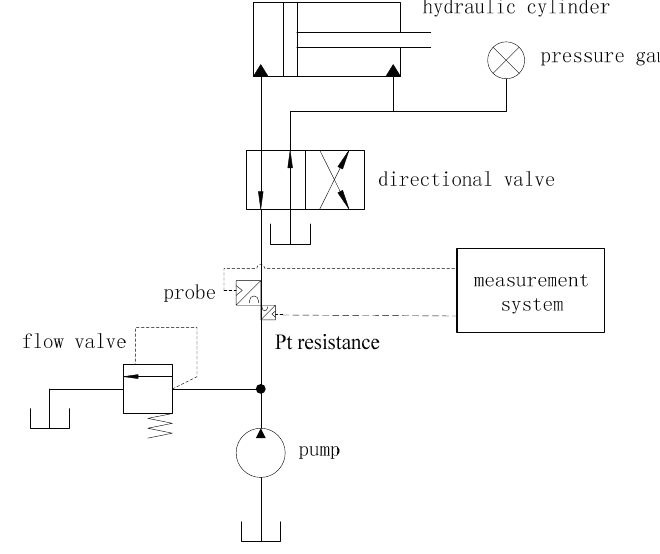
Figure 5. Schematic diagram of the experimental